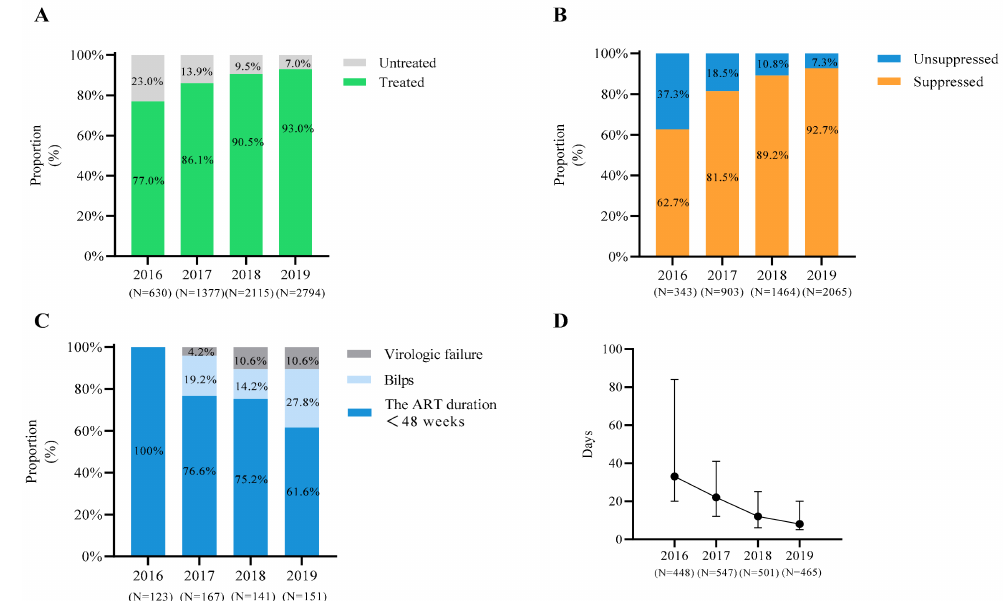
Figure 1. Status of ART among newly diagnosed PLWH in Shenyang during 2016 to 2019: ( A ) the green regions represent ART cumulative coverage among surviving HIV-infected individuals; ( B ) individuals receiving ART are grouped based on VL data, with each color representing a different group; ( C ) the histogram shows the details of the unsuppressed group; ( D ) the black dots represent the number of median days between diagnosis and ART initiation for newly diagnosed PLWH, and the short lines represent the first and third quartiles,